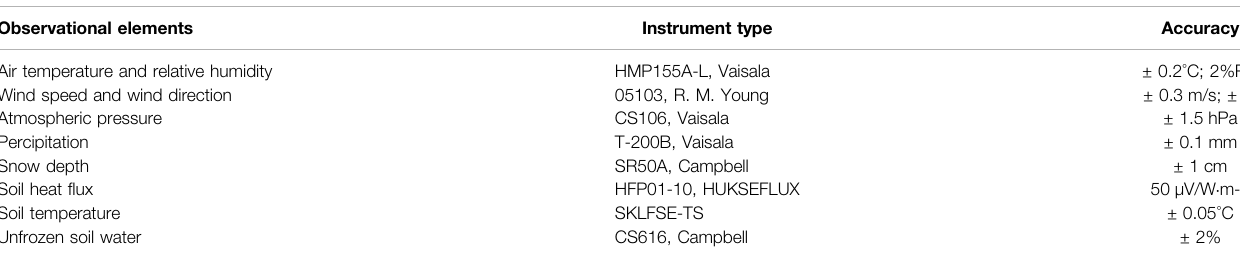
TABLE 1 | List of measurements used in this